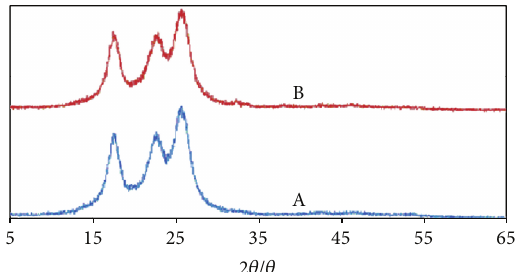
Figure 2: XRD patterns of polyester fabric (A) before loading and (B) after loading with nanometal